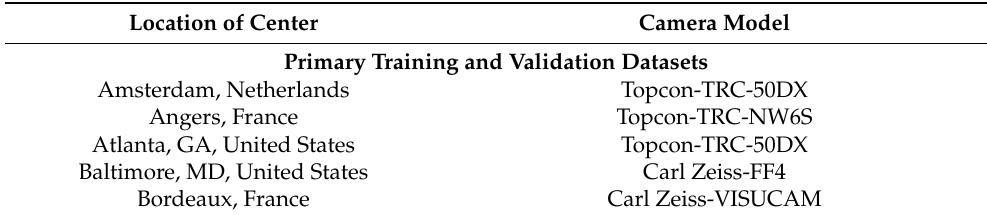
Table A1. Summary of Training, Validation, and Testing Data Sets, According to Location of Center and Camera